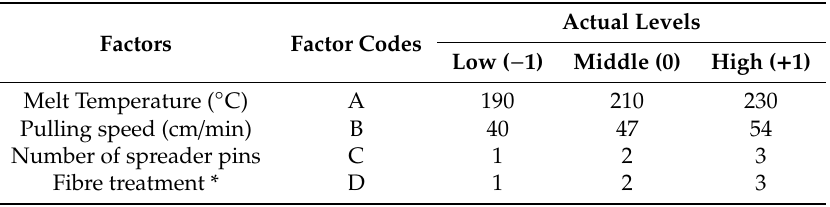
Table 2. Processing factors and